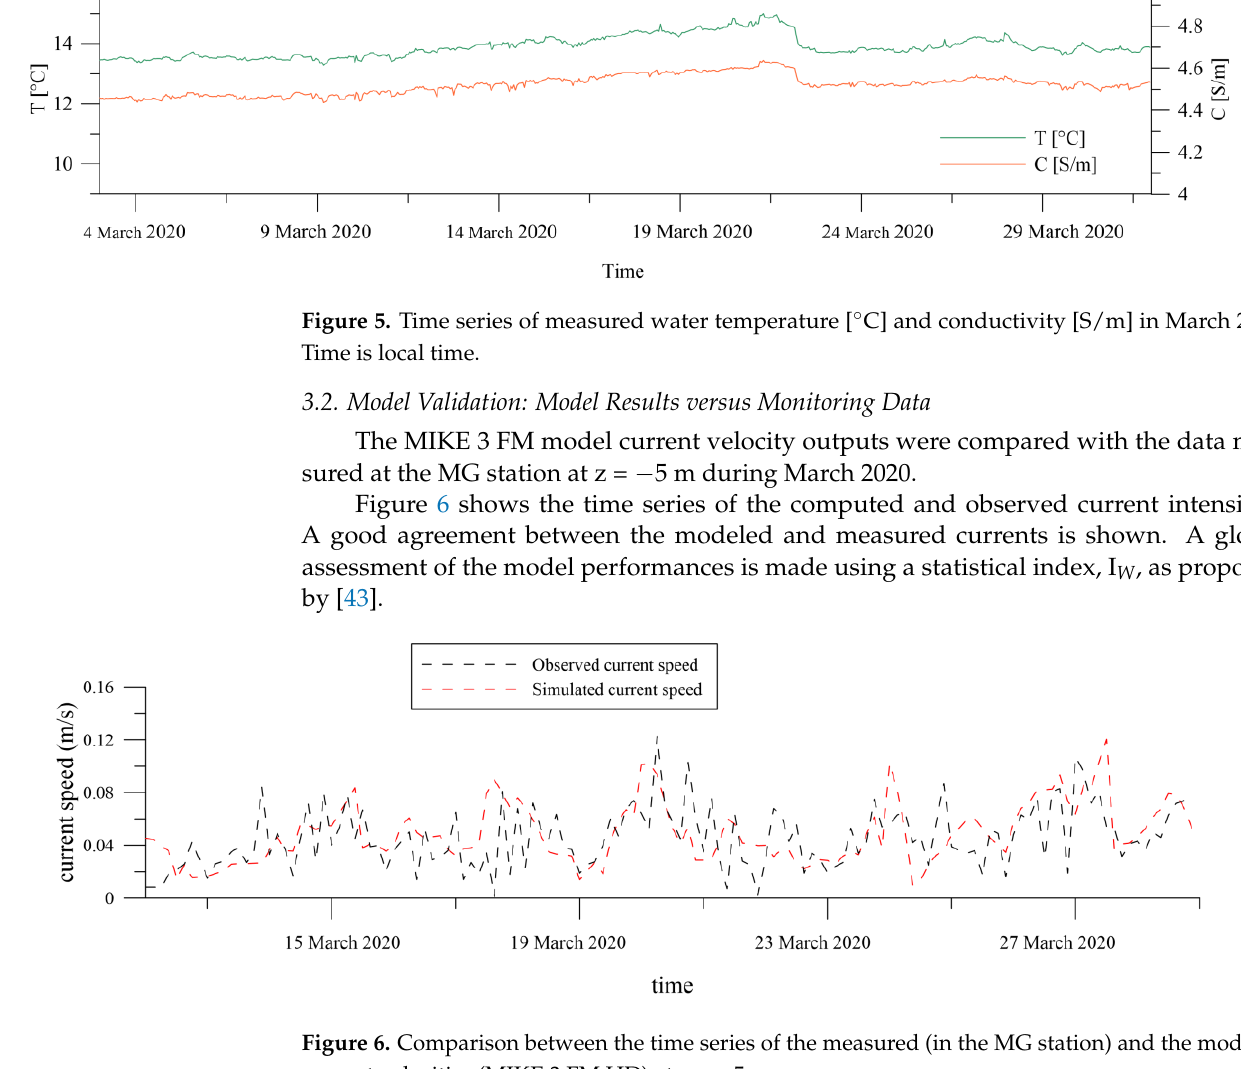
Figure 4. Polar plot of measured ( a ) wind and ( b ) waves in March 2020.